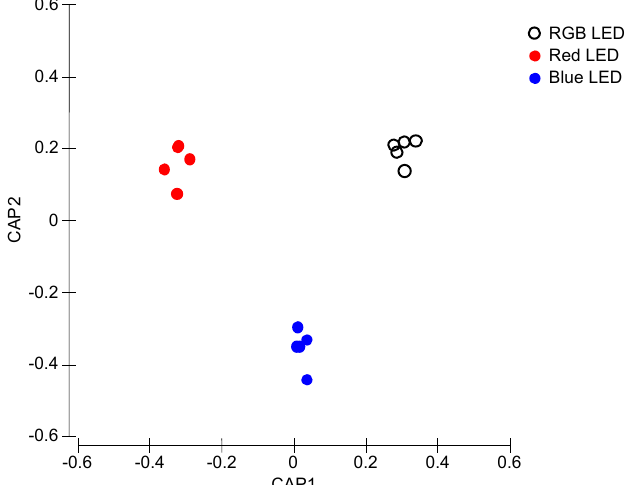
Figure 4. Canonical Analysis of Principal (CAP) components of the P. tricornutum cultures ( N = 5) subjected to the three light treatments, having as basis the full Kaustky fluorescence profile at the end of the 96 h exposure period (100% classification efficiency).